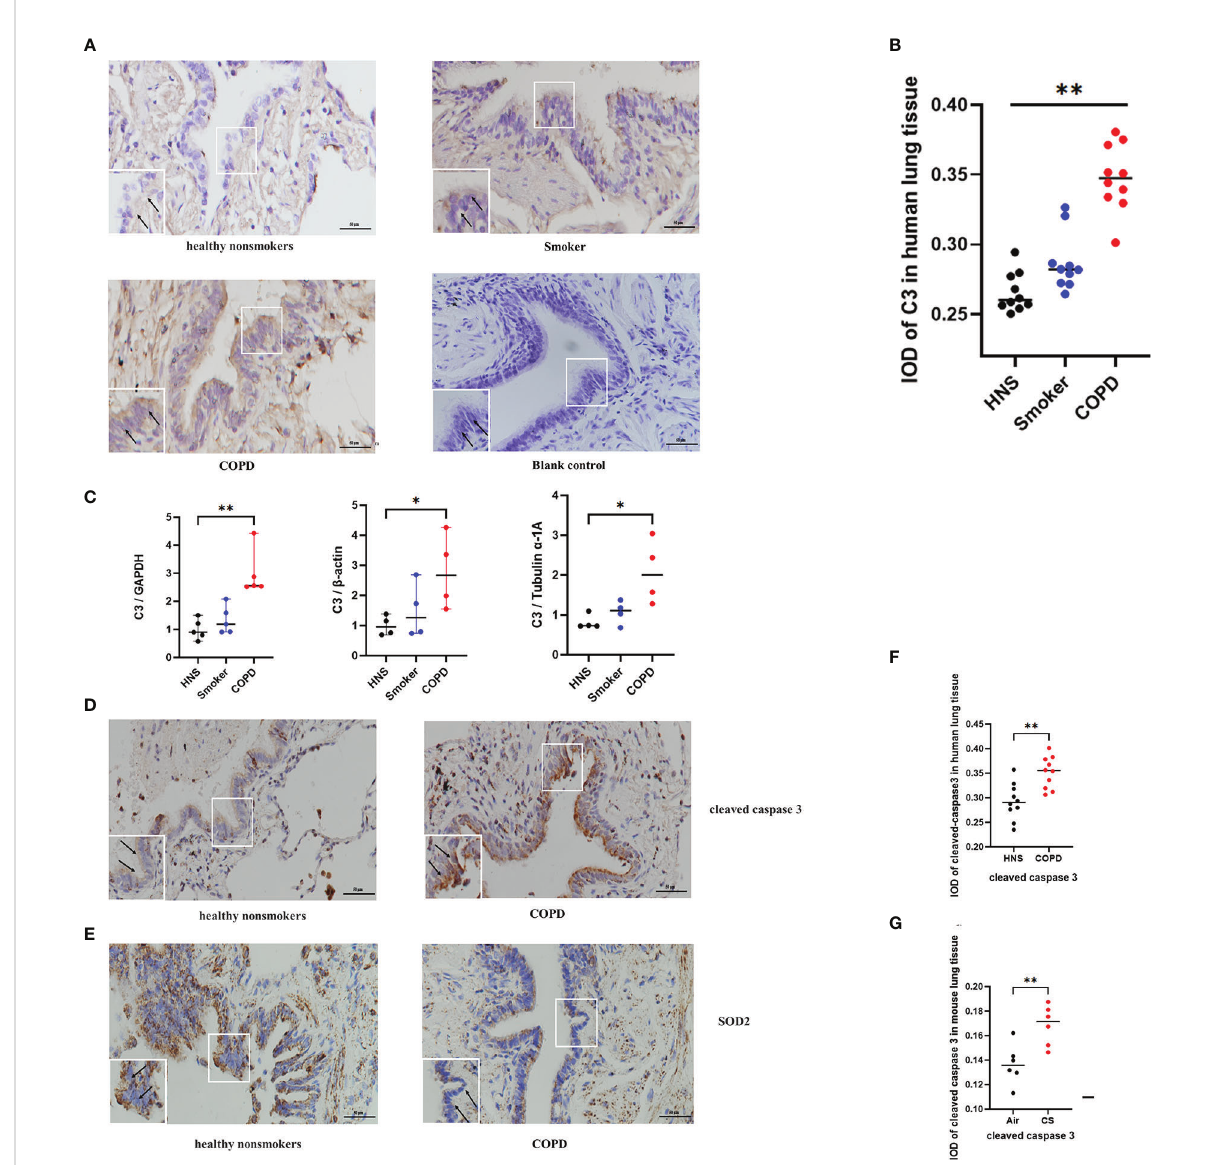
FIGURE 2 C3, cleaved caspase 3, and SOD2 expression was upregulated in AECs from patients with COPD. (A) Representative immunohistochemical staining of C3 in AECs of HNS, smoker, and COPD groups. (B) The integrated optical density (IOD) in immunohistochemistry of C3. N = 10 per group. ** P < 0.01. (C) C3 mRNA expression in lung tissue homogenates from HNS, smoker, and COPD groups were detected by qRT-PCR; N ≥ 4. * P < 0.05, ** P < 0.01. (D, E) Representative immunohistochemical staining of cleaved caspase 3 and SOD2 in lung sections of HNS and patients with COPD. (F, G) The IOD in immunohistochemistry of cleaved caspase 3 and SOD2. Data were expressed as group median values. N = 10 per group. * P < 0.05, ** P < 0.01. Original magni fi cation, ×400; scale bars: 50 mM for each fi